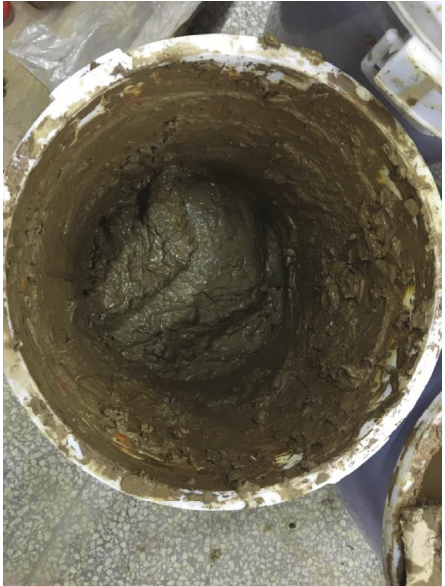
Figure 1: Soil slurry at initial